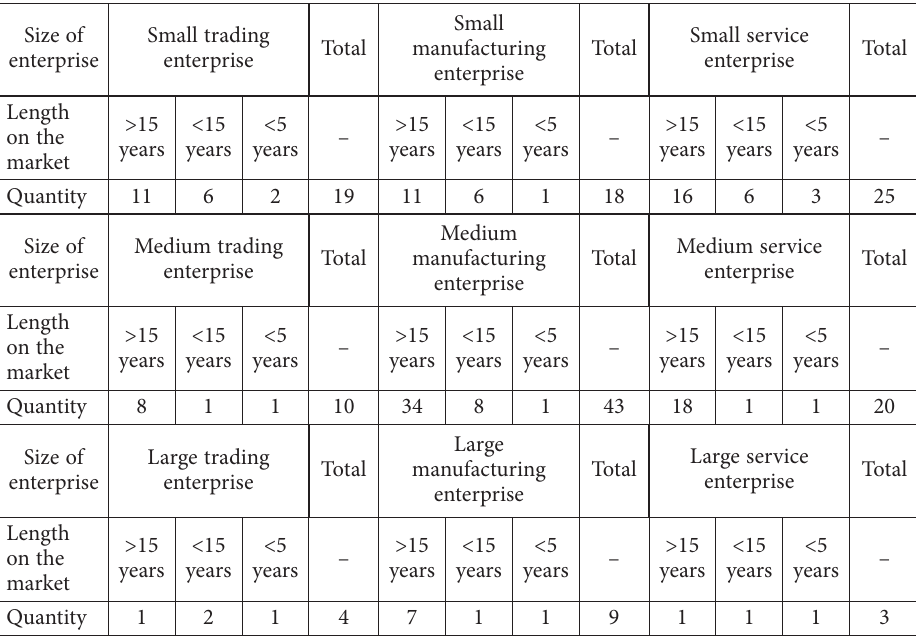
Table 1. Structure of the survey